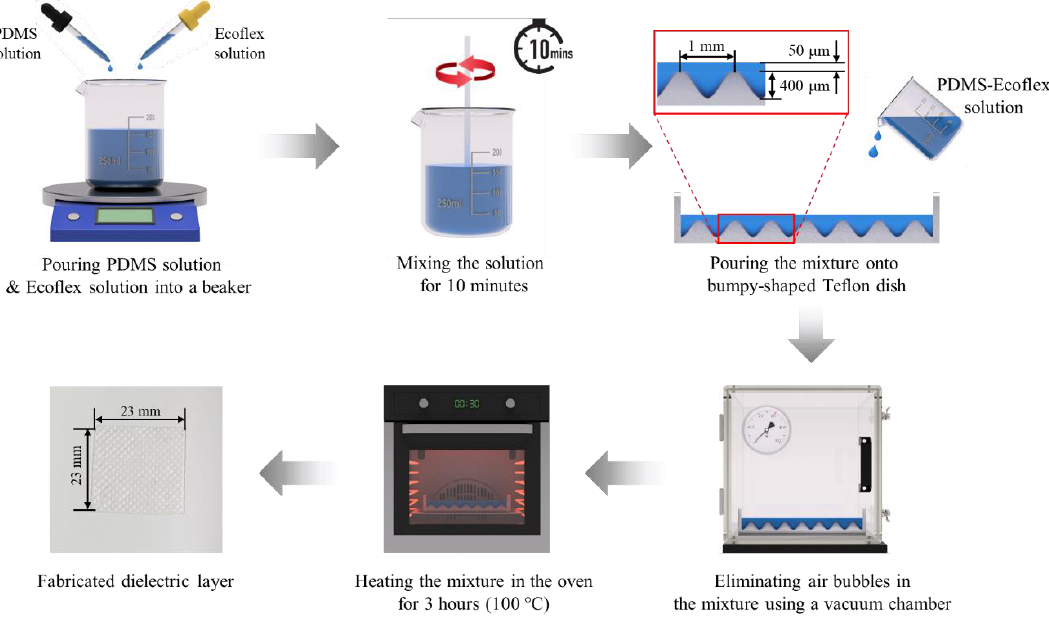
Figure 3. Fabricating process of the dielectric layer.